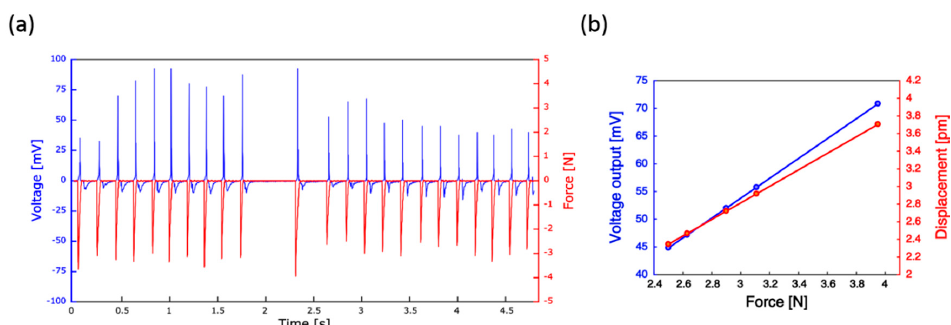
Figure 9. Pressure-sensing test. ( a ) Applied force (red) and sensor voltage response (blue) signals acquired during a trial. ( b ) Numerical results of displacement (red) and voltage (blue) output as function of the mechanical load applied by the operator.